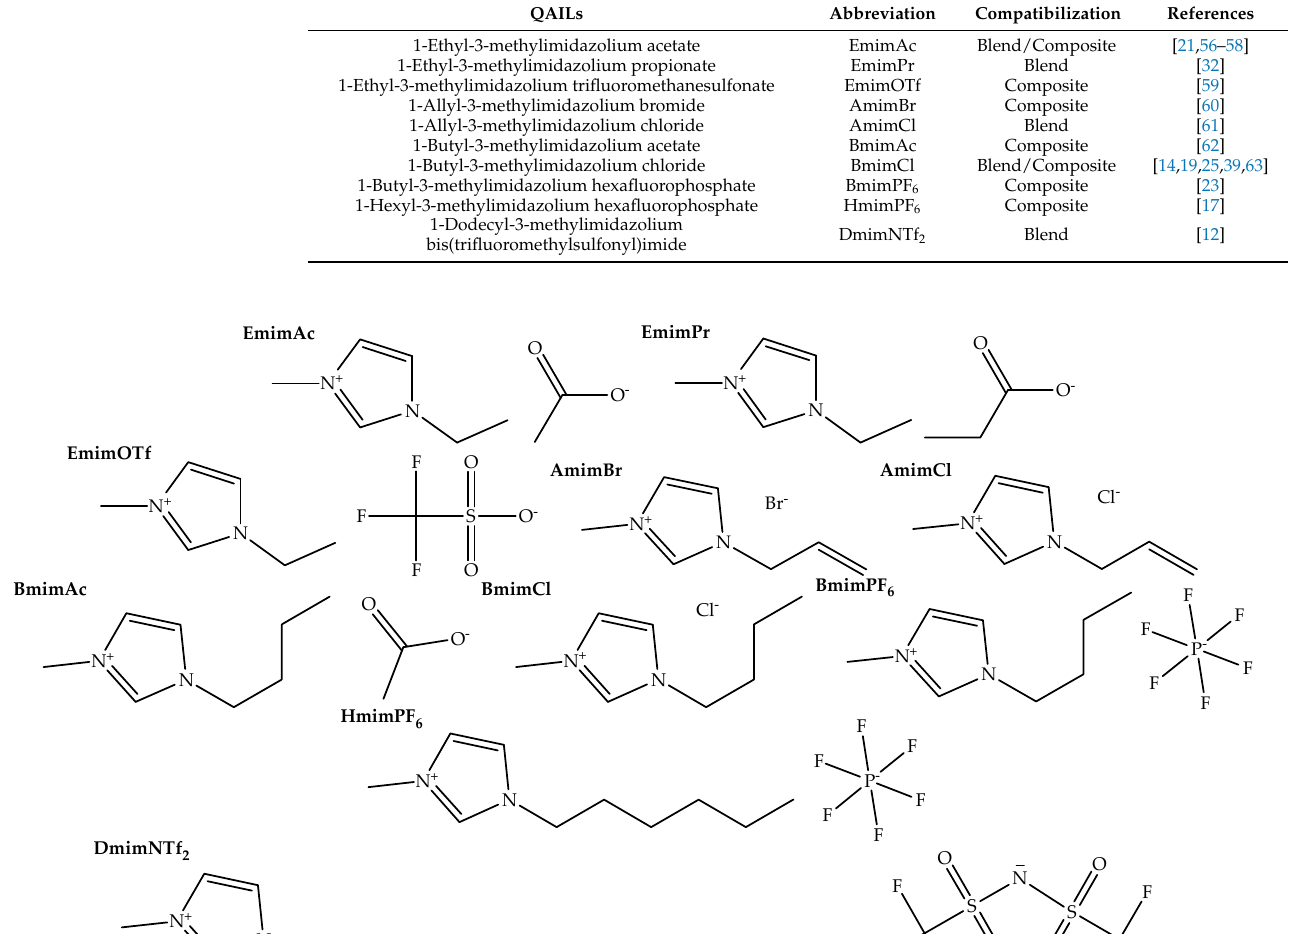
Table 6. Examples of quaternary ammonium ionic liquids (QAILs) applied for compatibilization of polymer blends and polymer composites.